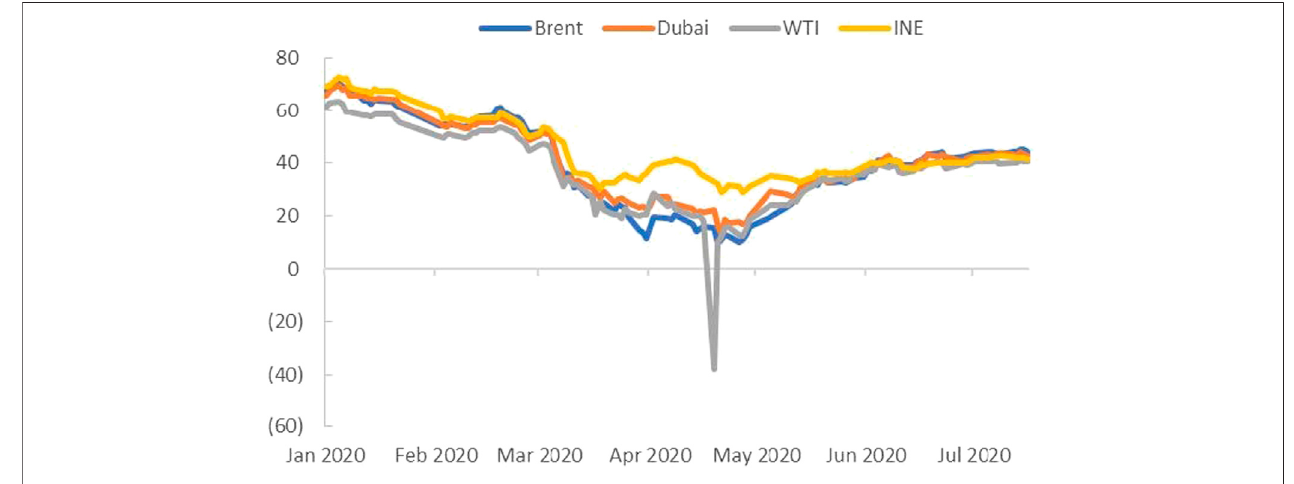
FIGURE 1 | Key oil contract settlements in 2020